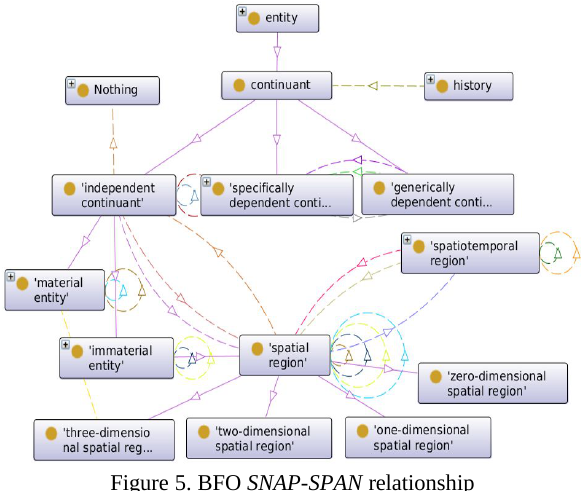
Figure 5. BFO SNAP-SPAN